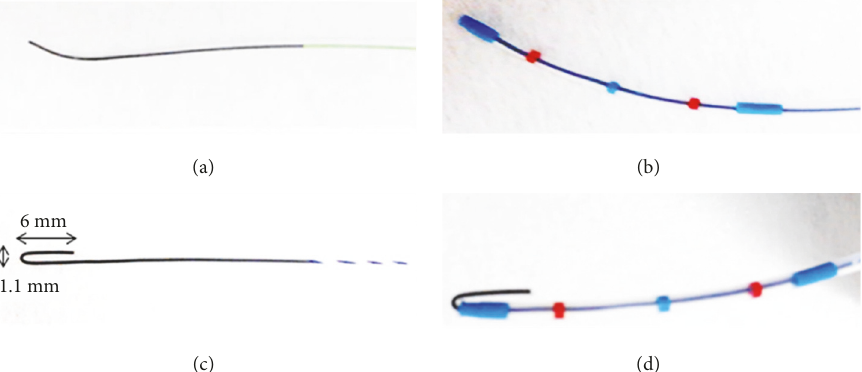
Figure 1: Guidewires. (a) Angle-tipped guidewire. (b) Neutral positions of angle-tipped guidewire. (c) Small J-tipped guidewire. The tip was bent to attain a 0.55-mm radius. (d) Neutral positions of small J-tipped